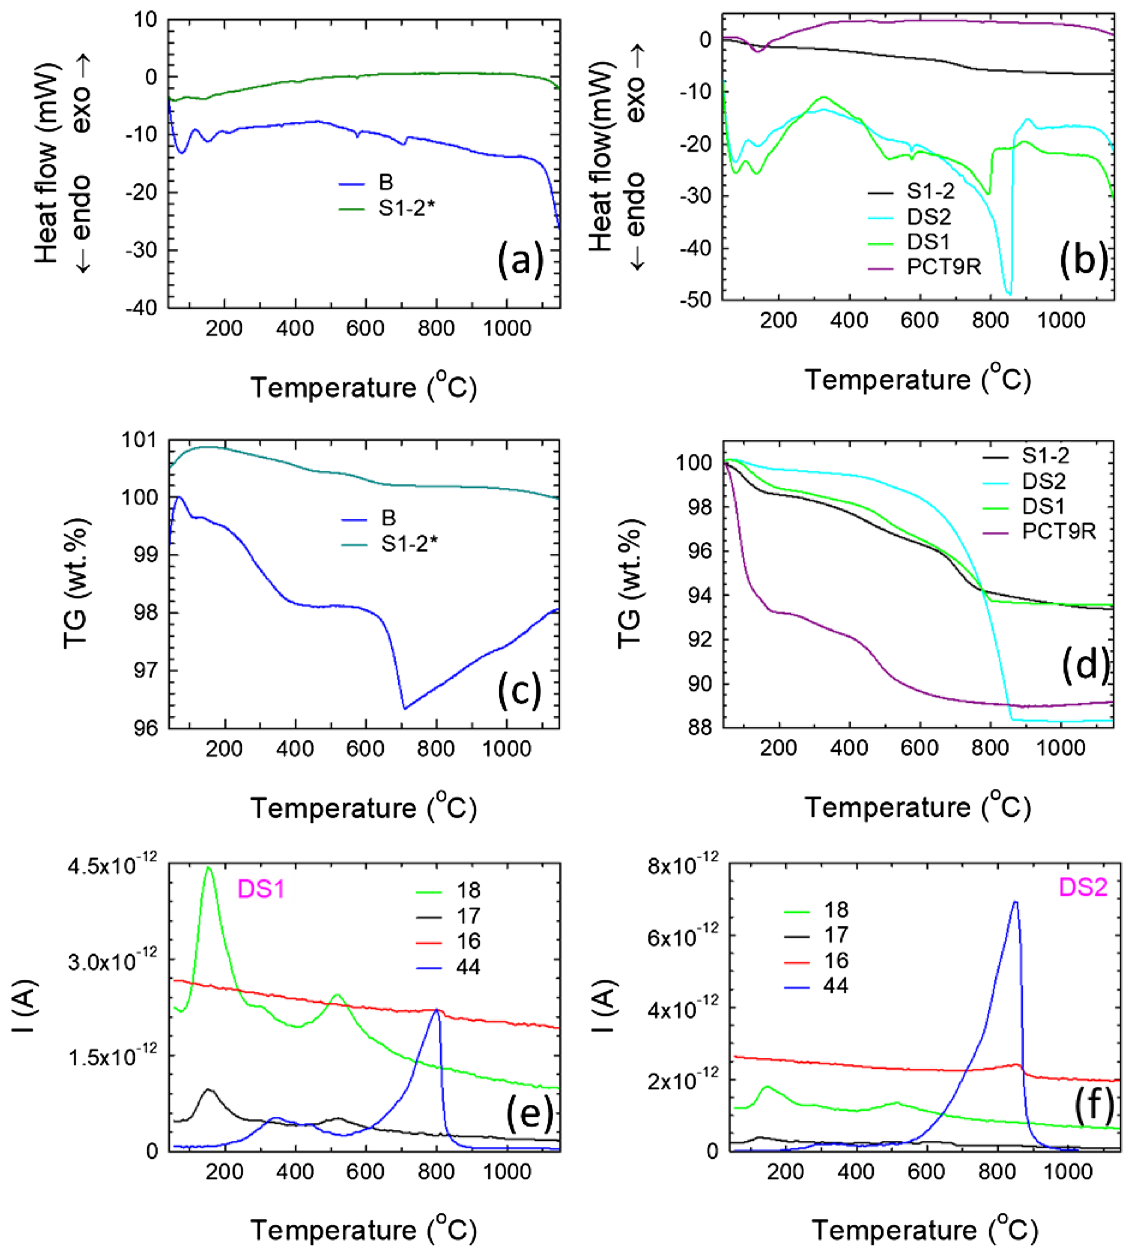
Figure 5. Thermal analysis and mass spectroscopy curves: ( a,c ) DTA and TG curves for samples B and S1–2 * ; ( b,d ) DTA and TG curves for PCT9R, DS1, DS2 and S1–2; ( e,f ) mass spectroscopy curves with temperature (fragments and/or molecules with mass 17, 18 and 44 were ascribed to OH, H 2 O and CO 2 ) for samples DS1 and DS2, respectively. Decomposition stages in DTA/TG for each sample are given in Supplementary material, Table